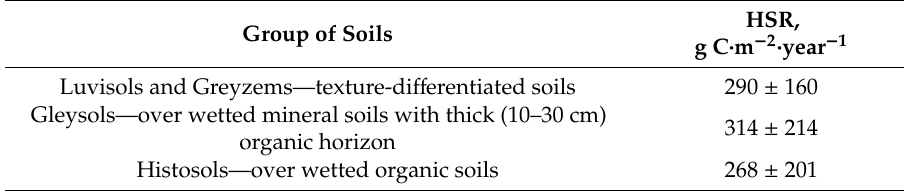
Table 5. Heterotrophic soil respiration (HSR) input data for the study